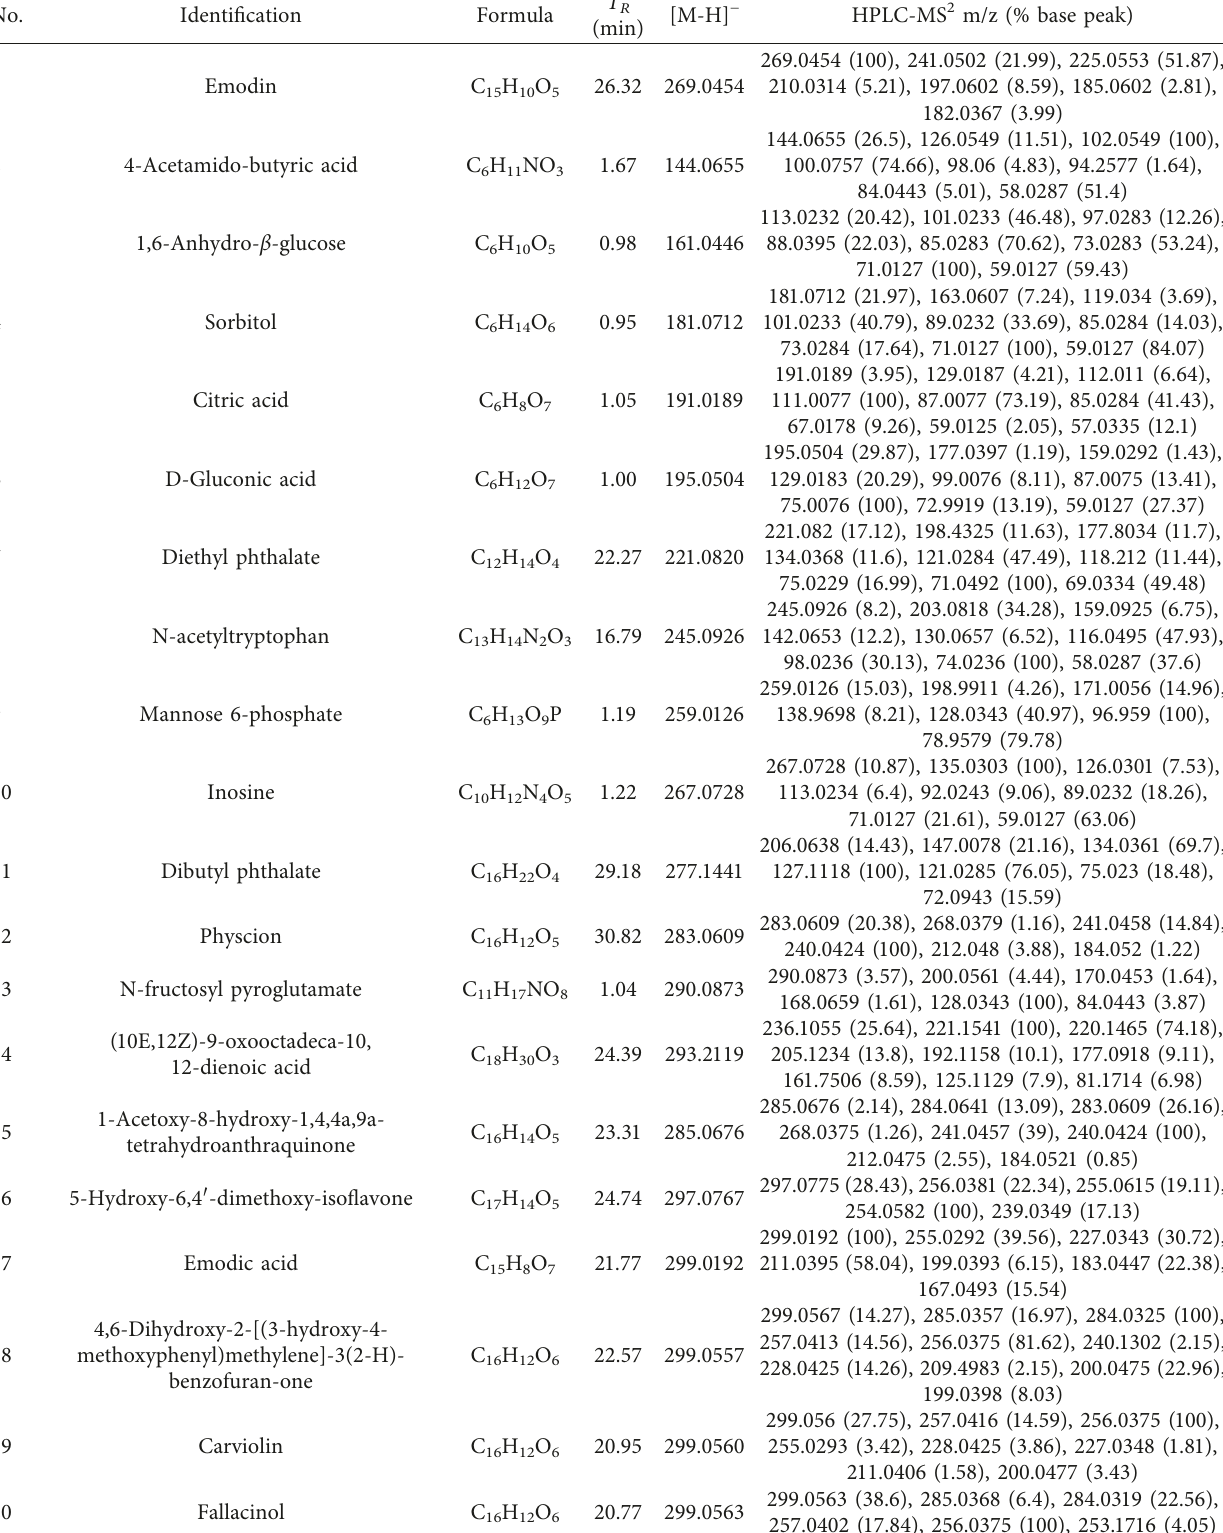
Table 1: Characterization of compounds in CEE using UHPLC-HRMS/MS-based